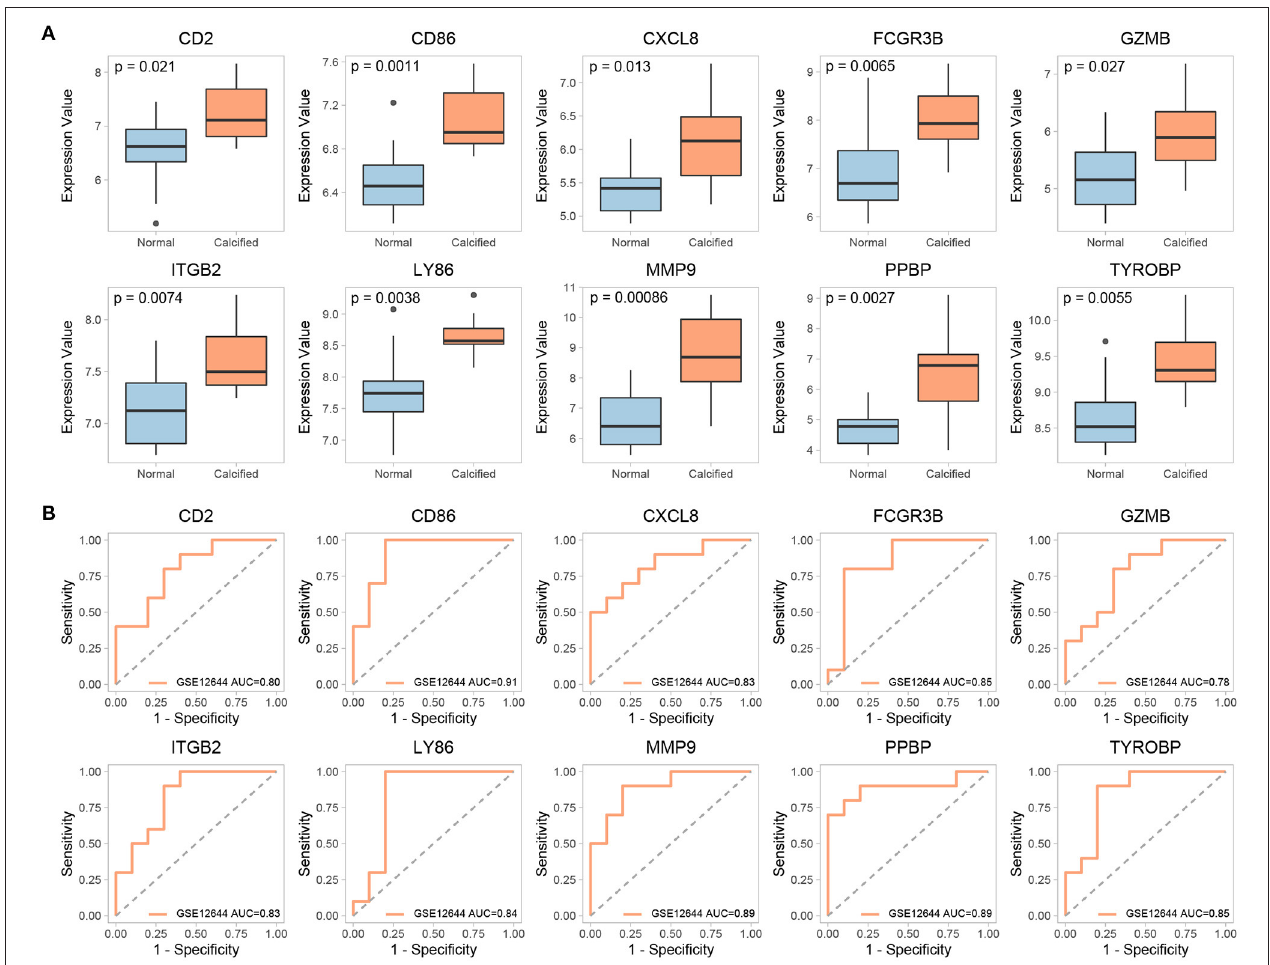
FIGURE 8 | Validation of differential expression and ROC analysis of key genes. (A) Validation of differential expression of key genes in the GSE12644 dataset. (B) ROC analysis of common differentially expressed key genes in GSE12644